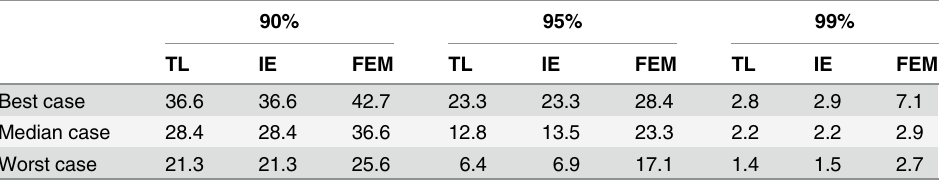
Table 2. Statistical evaluation of the compression of the SEP data, p -values of the statistical evalua- tion of the compression of the SEP data, using the Mann-Whitney U test. TL vs. IE TL vs. FEM IE vs. FEM 90% 0.973236 0.096671 0.096671 95% 0.620494 99% 0.490152 0.000081 0.000106